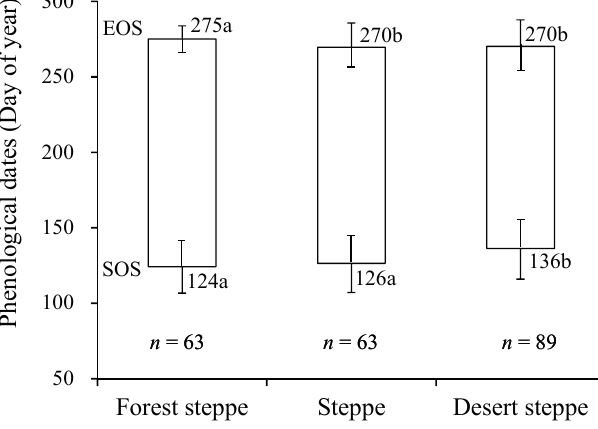
Figure 2. Means and standard deviations of SOS and EOS for three steppe types in Mongolia. The n is the number of phenological records for SOS and EOS. The bar is the standard deviation. The same letters following mean values indicate no significant difference in SOS and EOS between three grassland types at the 5% significance level,